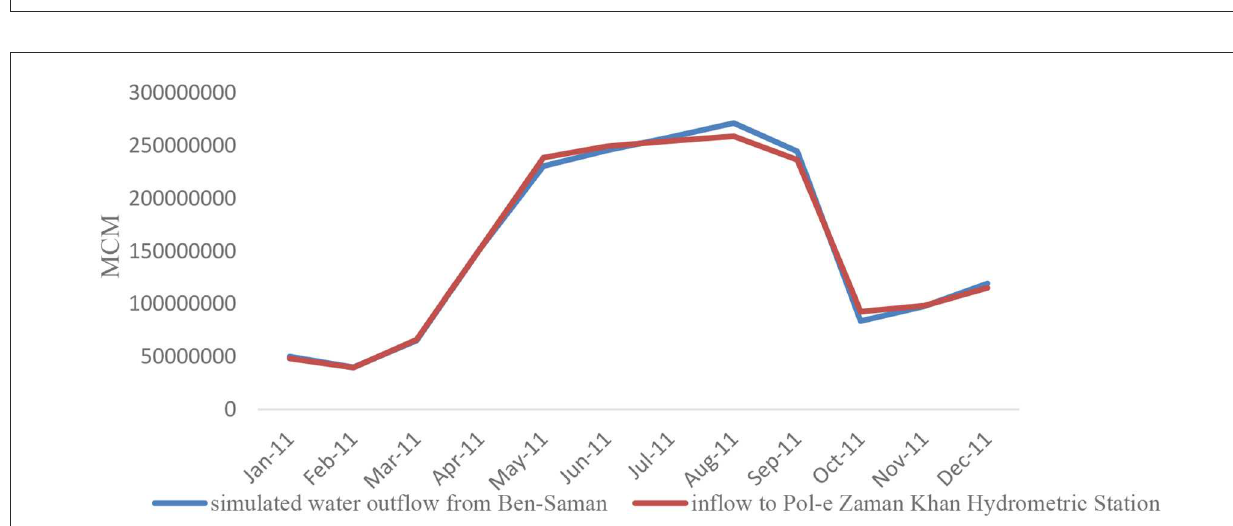
FIGURE4 The comparison of observational data on the flow volume of the river with the simulated